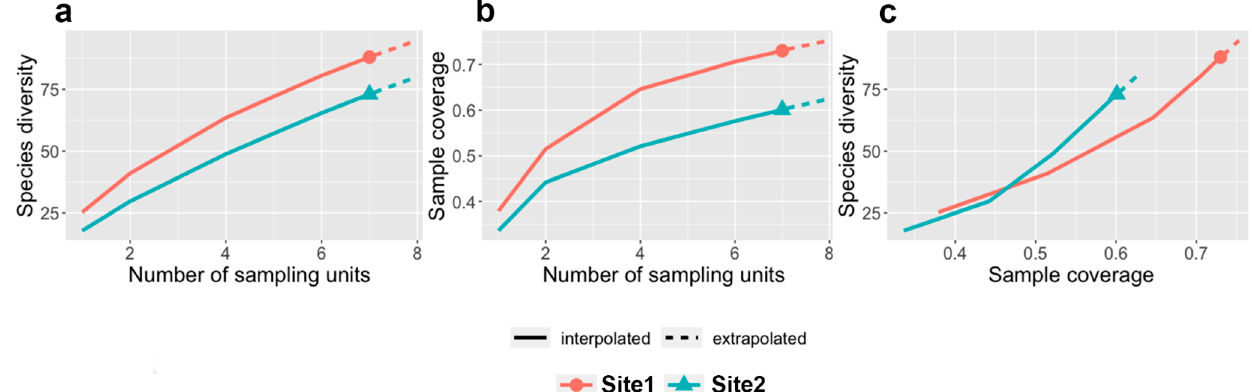
Figure 2. Rarefaction curves: ( a ) Sample ‐ size ‐ based rarefaction curves on species richness considering all the species; ( b ) Sample ‐ size ‐ based rarefaction curves on sample coverage considering all the species; ( c ) Sample coverage rarefaction curves on species richness considering all the species.